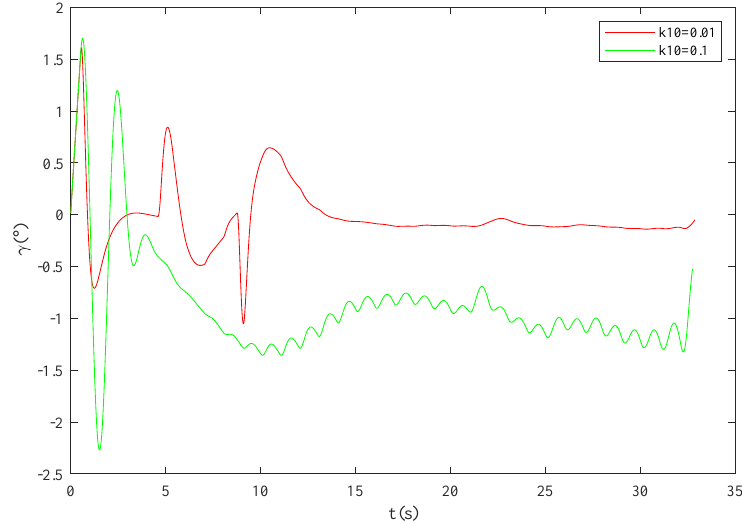
Figure 13. Roll angle response curve under drifts